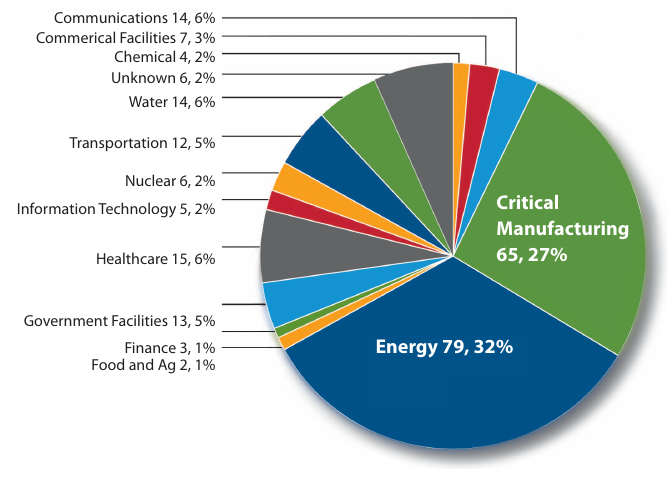
Figure 1. FY 2014 incidents reported by sector (245 total). Figure 1. ICS-CERT Monitor report 2014/15